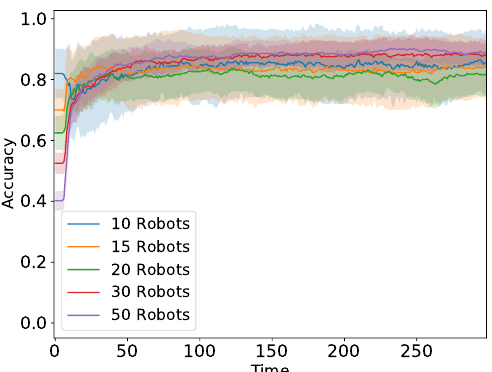
Figure 13. Temporal evolution of the accuracy of the robot’s classification in the borderline identifica- tion experiment for diverse swarm sizes. The darker curves represent the median of the accuracy using all 50 collected samples. Alternatively, the shadow areas indicate, at each time instant, the first and third quantiles of the